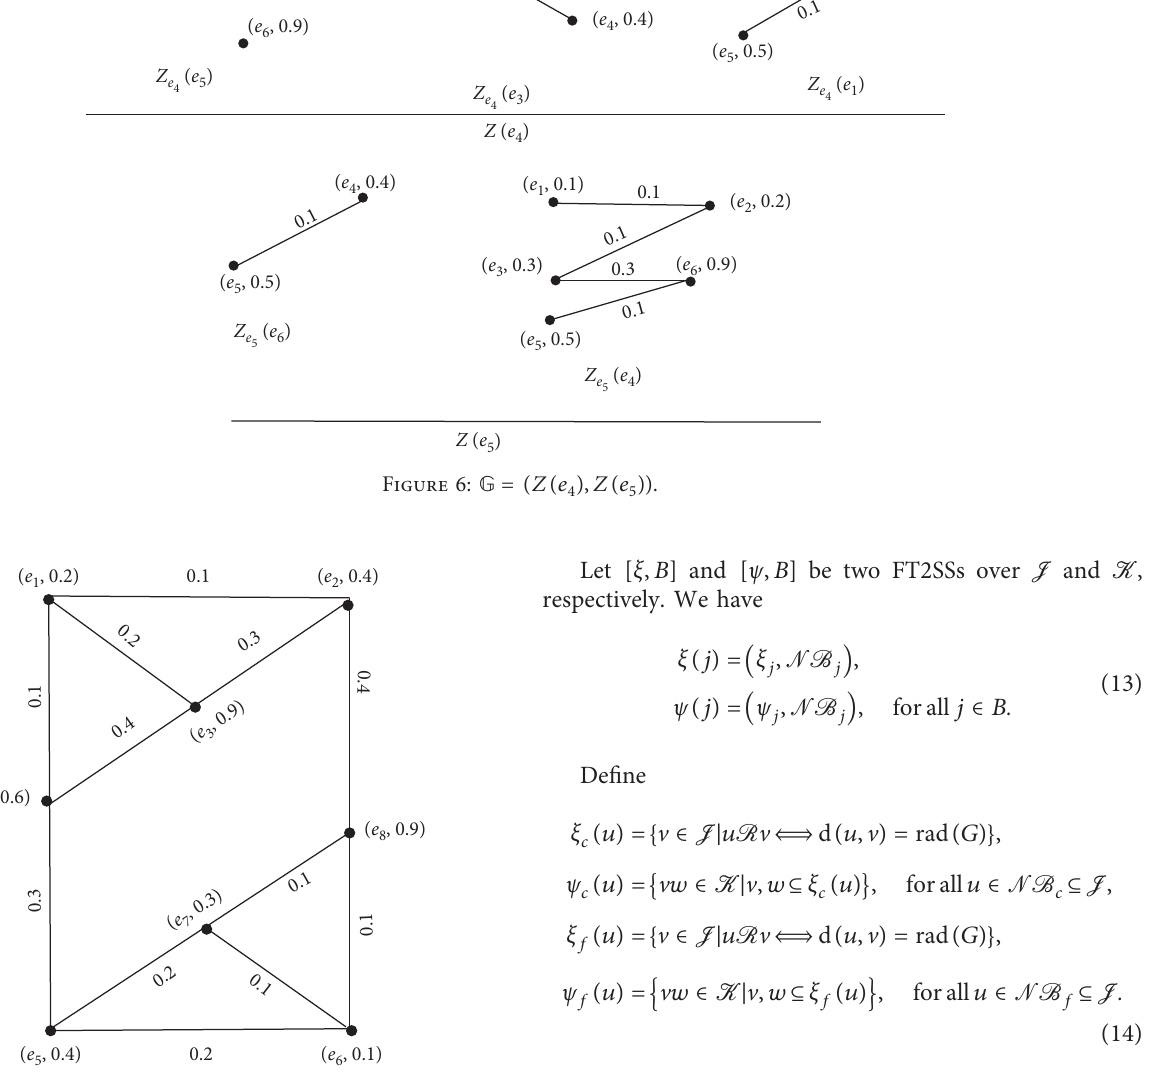
Figure 7: Fuzzy graph G � ( J , K ) .